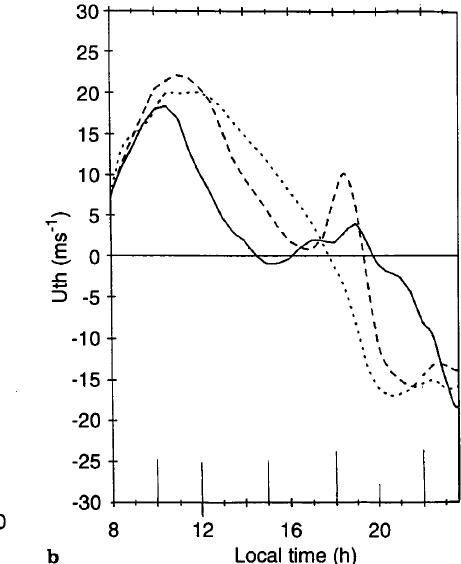
Fig. 8. a Meridian section with NV flow vectors, SUPIM model for Brazil Summer 1100 LT, solar flux F10.7 (cid:136) 85. f : trough; (cid:68) : tropical crest; - - - -: hMF2 line. b Jicamarca Vz(LT) curves for three seasons